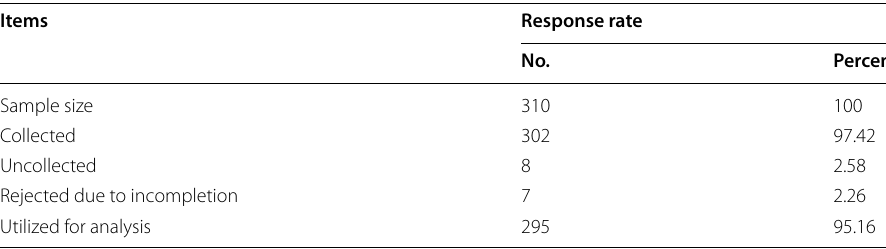
Table 2 Response